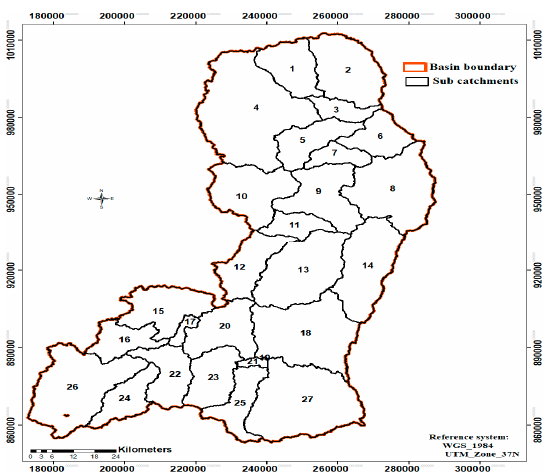
Figure 10. Illustrative catchment numbers to identify priority orders for treatment. Table 10. Soil loss variation under constant LULC and changing climate under RCP scenarios.